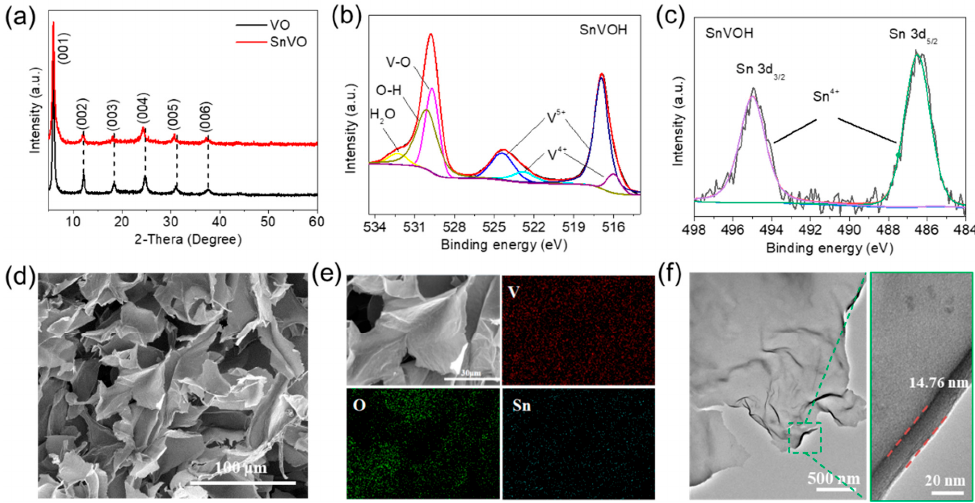
Figure 1. Characterization of SnVOH. ( a ) XRD patterns of SnVOH sample; ( b ) XPS spectra of ( b ) O1s and V 2p and ( c ) Sn 3d; ( d ) SEM of SnVOH sample; ( e ) EDS mapping of SnVOH sample; ( f ) TEM of SnVOH sample.